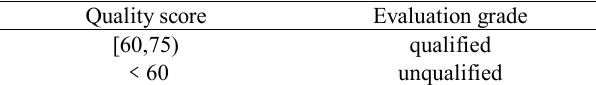
Table 2. Interval division of evaluation